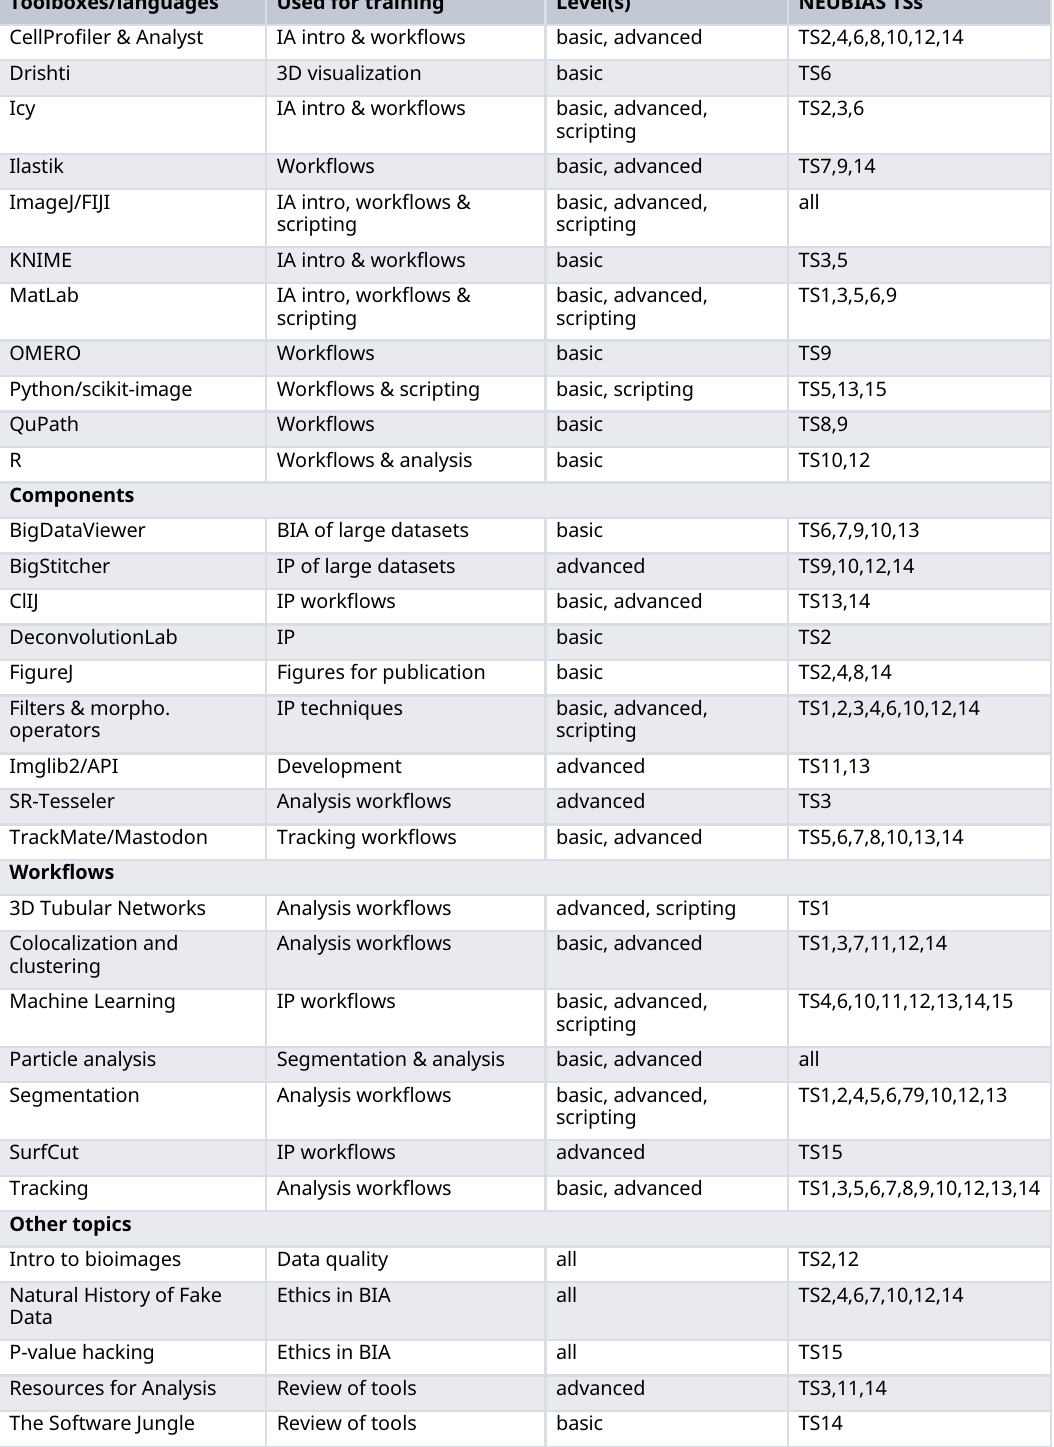
Table2.Examplesofopen-sourcetoolboxes,componentsandworkflowsusedduringNEUBIASTSs. These,and many others, are catalogued in Biii.eu with links to access the training materials from public repositories such as Zenodo and